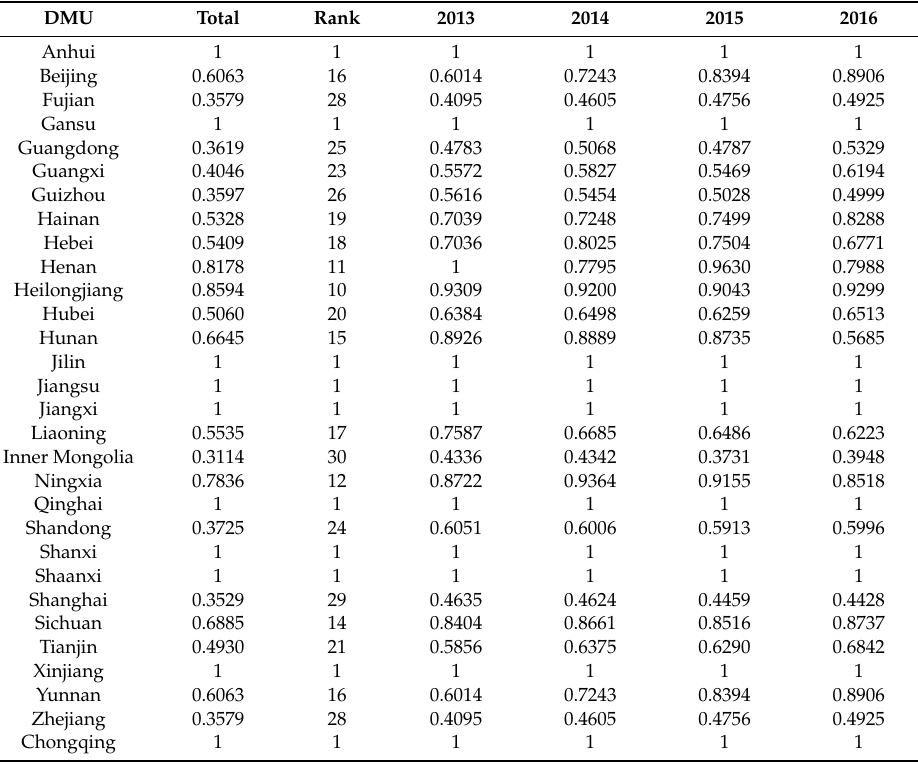
Table 2. E ffi ciency by city from 2013 to